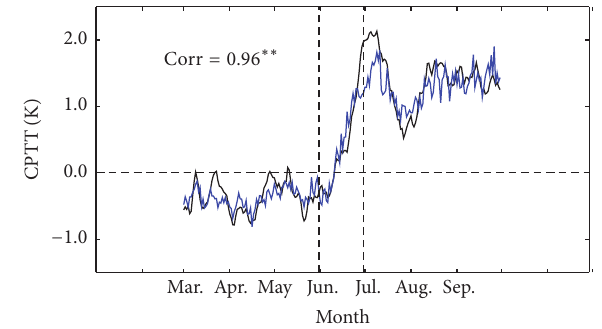
Figure 9: Regressed (blue line) and observed (black line) CPTT daily time series. For details on the regression, please see Section 4. “Corr” represents the correlation coefficient between observed and regressed CPTTs for 1999. “ ∗∗ ” denotes that the correlation coefficients exceed the significance test at the 95% confidence